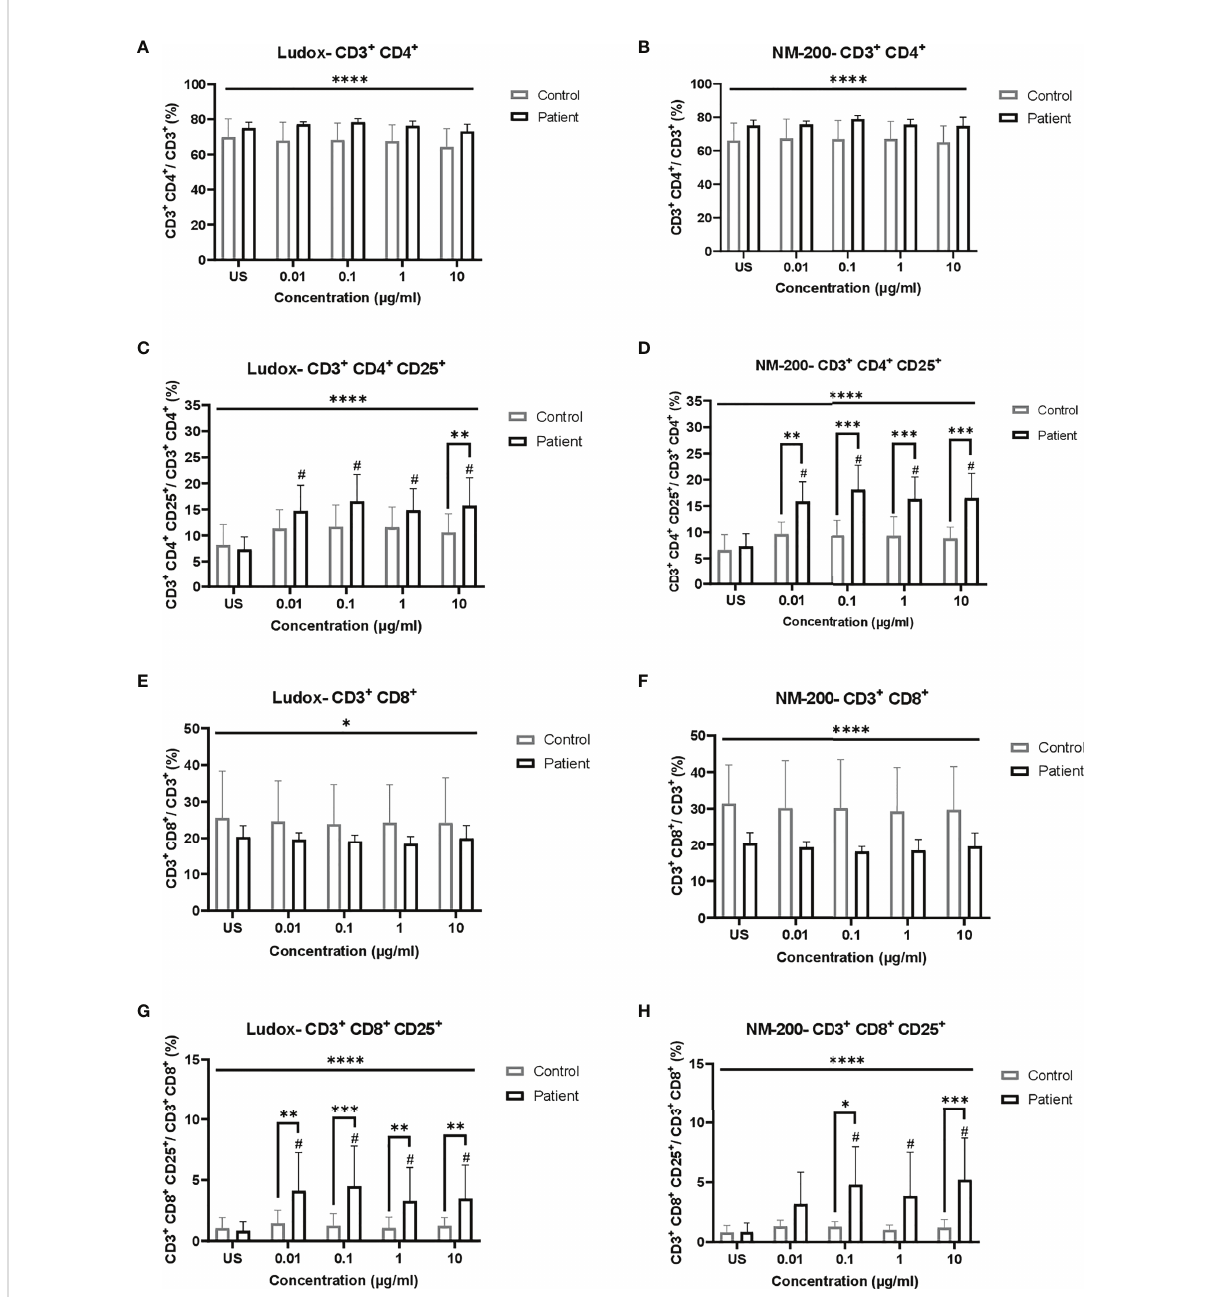
FIGURE 1 (A – H) Comparing the percentage of total and activated populations of CD3 + CD4 + and CD3 + CD8 + when exposed to SiNPs across both groups of individuals. Percentages of total (A, B, E, F) lymphocyte subpopulations of CD4 + (A, B) and CD8 + (E, F) , and activated (CD25 + ; C, D, G, H ) subsets of CD4 + (C, D) and CD8 + (G, H) , were compared between silicotic and control groups. Tukey ’ s multiple comparisons tests via two-way ANOVA was performed to determine signi fi cance of SiNP-stimulated conditions against unstimulated condition within each subject group, # signi fi cant at p < 0.05 and between the two groups of subjects per exposure condition; *p < 0.05, **p < 0.01 and ***p < 0.001. ANOVA F-tests or level of signi fi cance between both groups regardless of exposure conditions are denoted by *p < 0.05 and ****p < 0.0001. Non-signi fi cance (NS) within and between groups are not included. US,